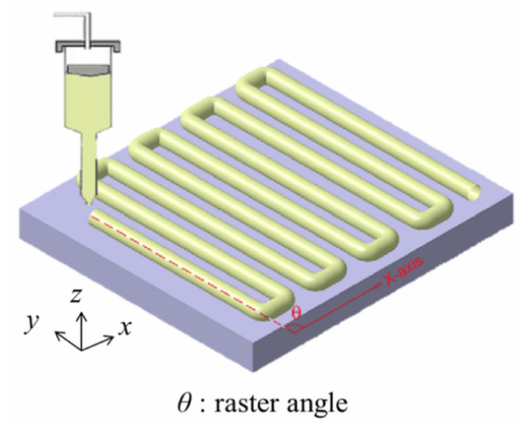
Figure 7. Schematic of raster angle.